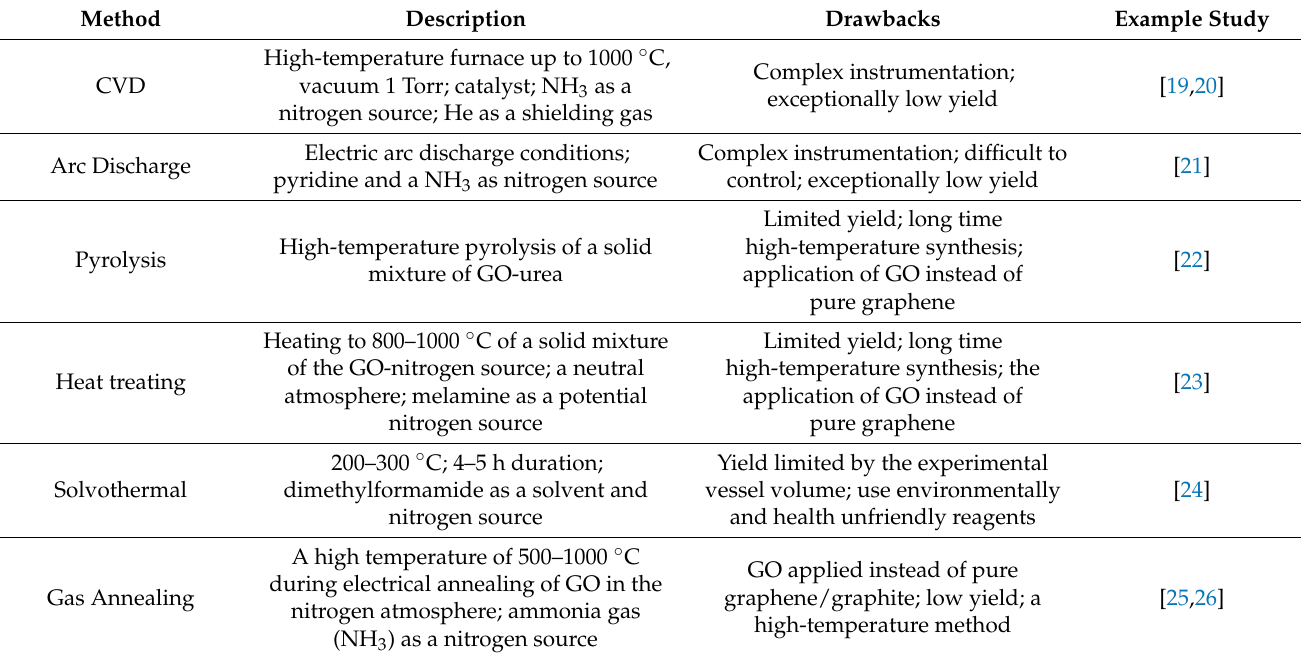
Table 1. An overview of currently practiced methods for nitrogen insertion into the relatively chemically inert graphene matrix